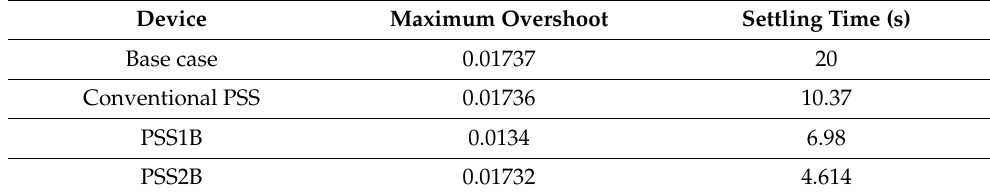
Table 10. Maximum overshoot and settling time of rotor speed deviation at normal loading.